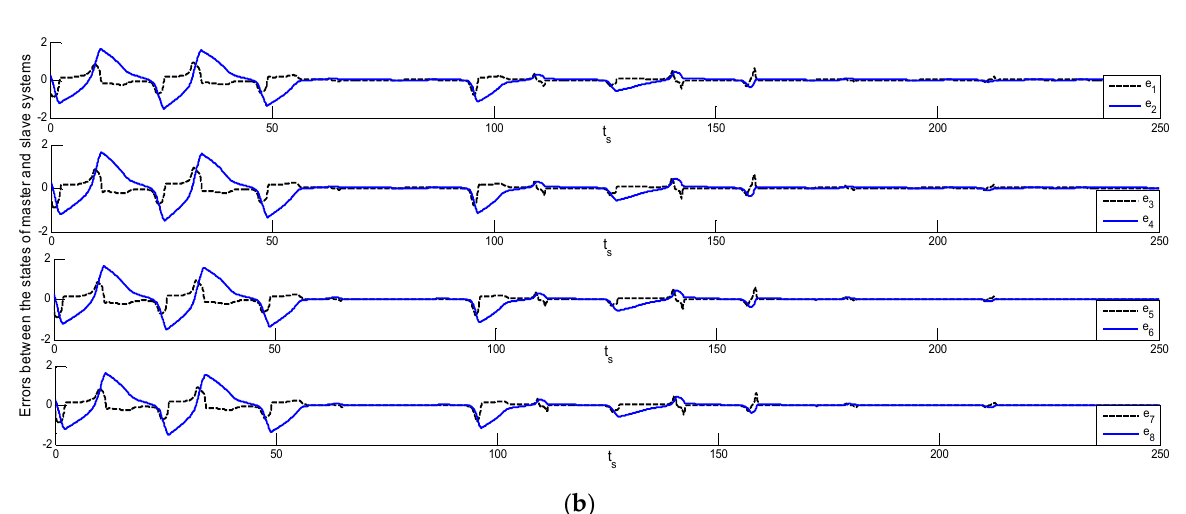
Figure 6. Errors between the state: ( a ) master; ( b ) four slave systems (X MO -X SIO ) of Theorems 1 and 2.